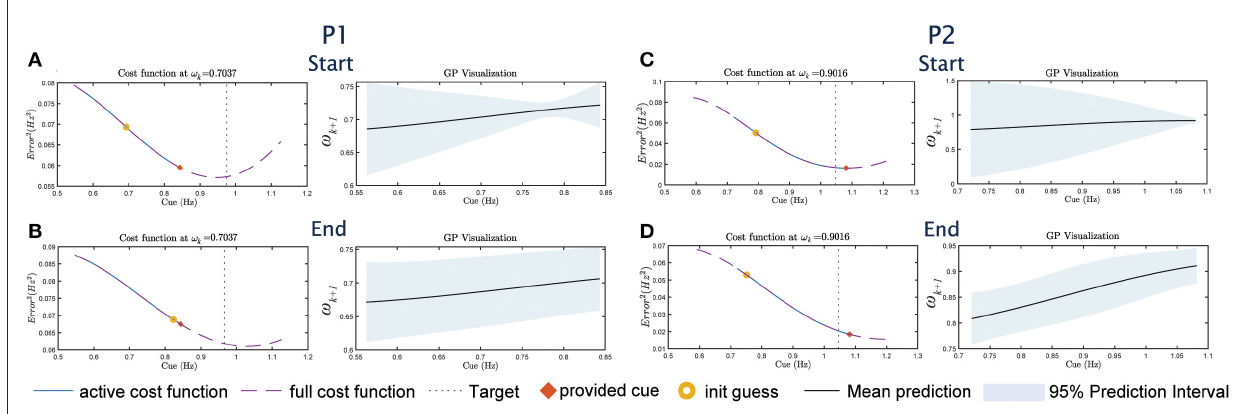
FIGURE4 The cost function/GP visualization sets for P1&2 for UP, following the format in Figures 3D–J. For P1, (A) shows the visualization at the start of the study, (B) shows the visualization at the end of the study. For P2, (C) shows the visualization at the start and (D) at the